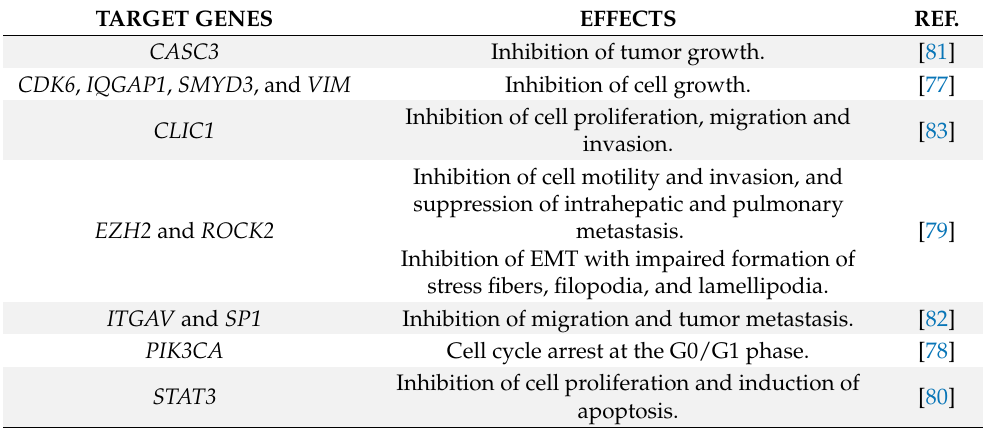
Table 4. Anti-tumor function of miR-124 in liver